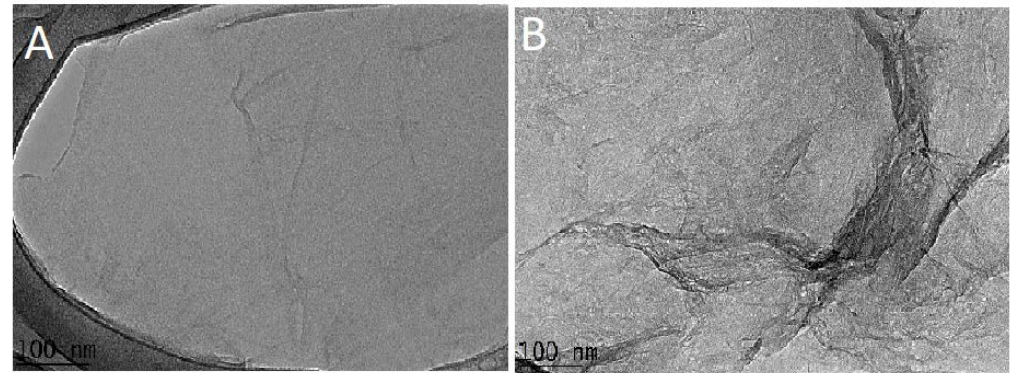
Figure 5. ( A ) HR-TEM image of GO and ( B )the nanocomposite GO-PEITC.